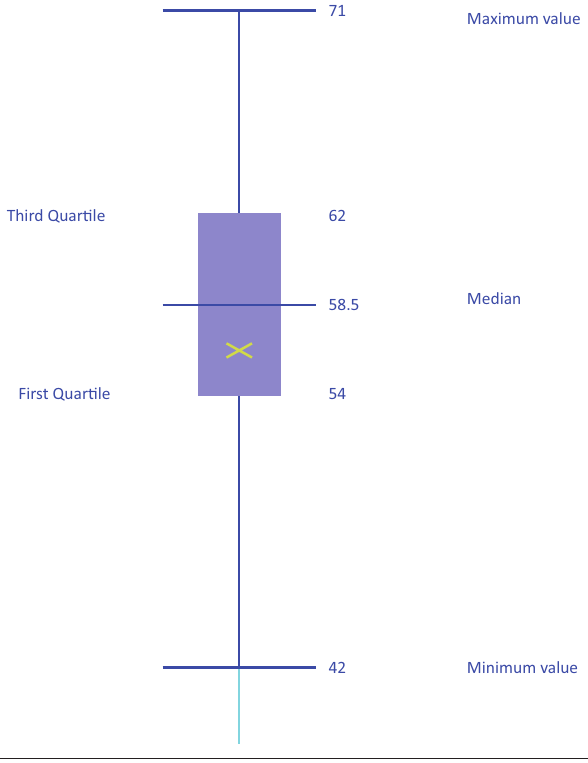
FIGURE 3: Boxer and whisker plot for teacher students’ TABLE 1: Some statistics on students’ performance on the tasks. Characteristics